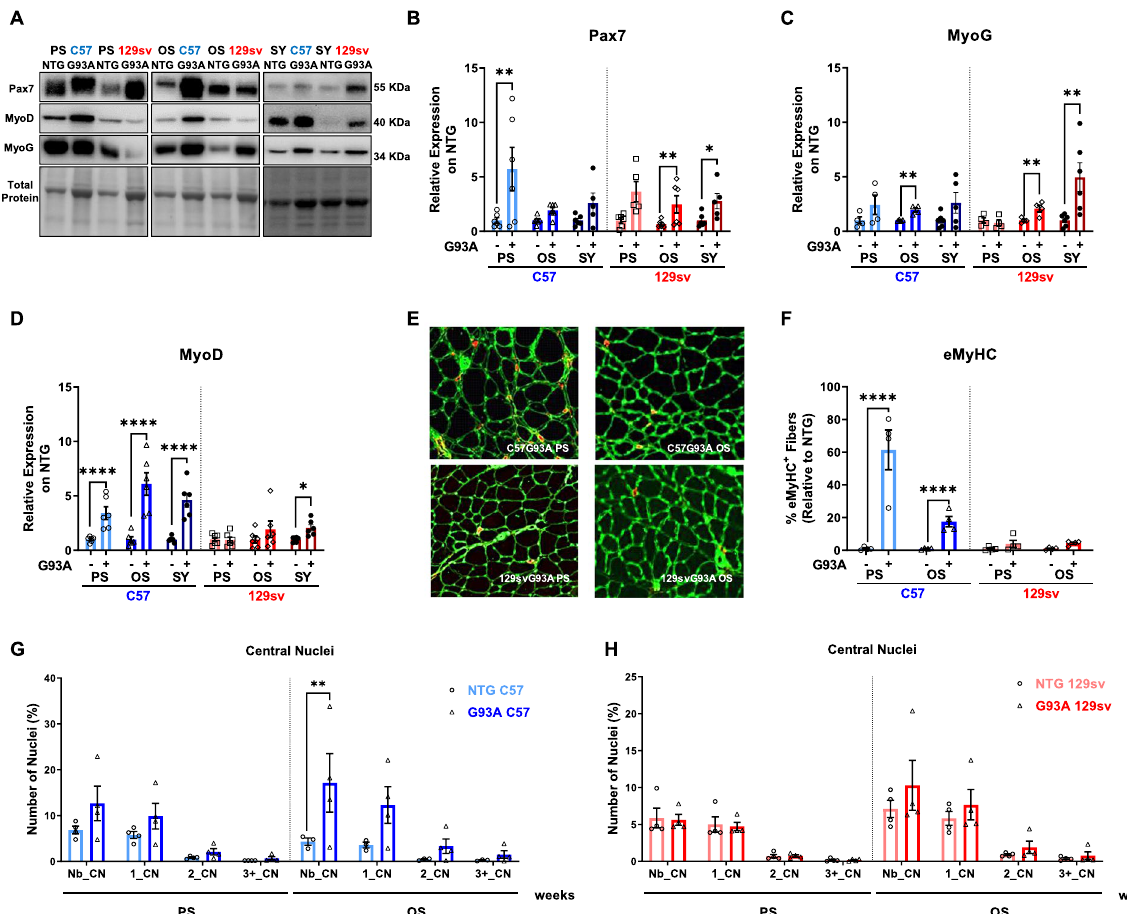
Fig. 5 Early muscle regeneration differentiates fast from slow-progressing mice ( A - D ). Representative immunoblot images (full blots images in Additional file 2) and relative densitometric analysis of Pax7 ( A and B ), MyoG ( A and C ), and MyoD ( A and D ) protein expression in GCM muscles